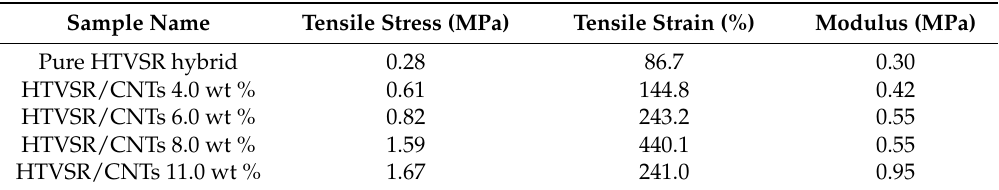
Table 9. Tensile properties of the HTVSR and the HTVSR/CNT nanocomposites. Reproduced with permission from [118], Copyright Elsevier,